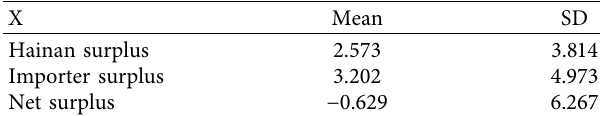
Table 8: Total surplus of importers and Hainan.